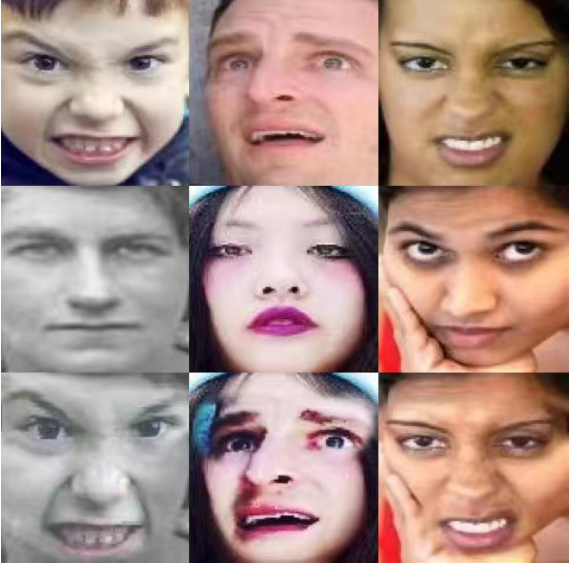
Figure 6. The image in the first row is the dataset that we need to expand, and we use it as the foreground image. The image in the second row is the head dataset, which will be used as the background image, and the image in the third row is our final fused new image, which we will use as the training